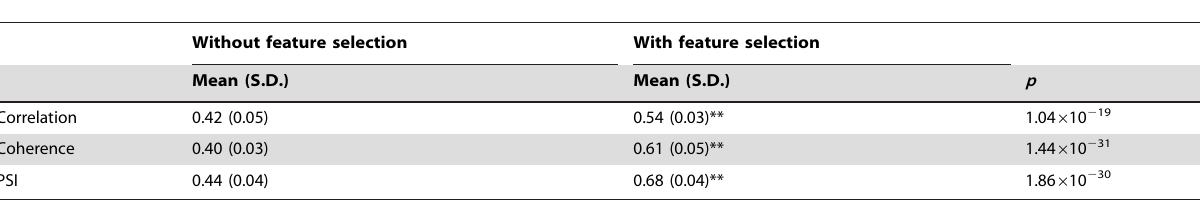
Table 10. Classification Accuracy when Feature Selection Process was Only Applied to The Training Data.